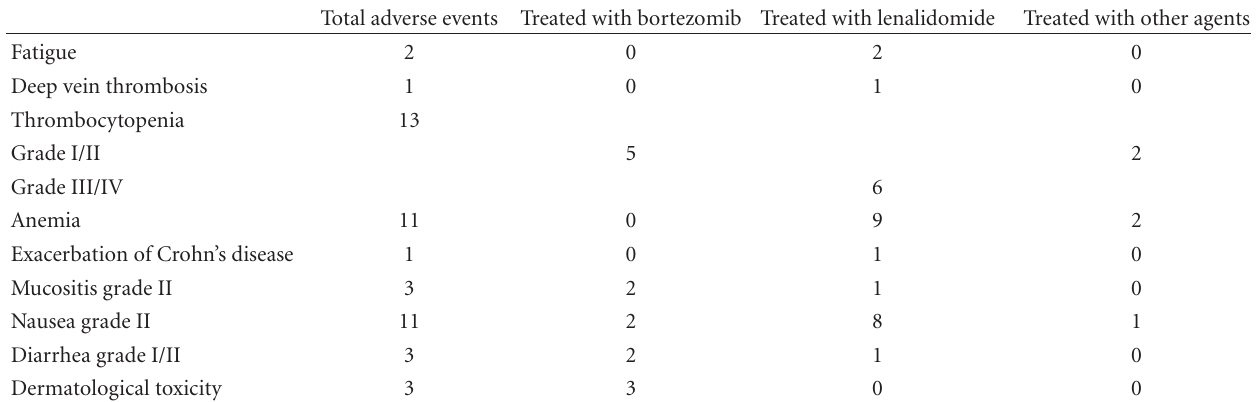
Table 2: Adverse